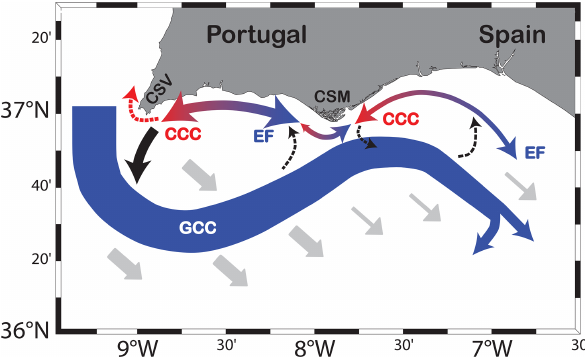
Figure 16. Updated sketch of the main circulation patterns at the NMGoC during the upwelling season for no-storm conditions. The flow magnitude (schematically represented by the size of the ar- rows) is larger at the western bight than at the eastern bight. Red (blue) arrows indicate the direction of warm (cold) water advec- tion. Dashed arrows indicate a transient (or sporadic) circulation. An equatorward slope current (the Gulf of Cádiz Current, GCC) proceeding from the west Portuguese coast and advecting cold wa- ter is superimposed to the background southeastward, wind-induced circulation (grey arrows). The GCC partly recirculates anticycloni- cally in the east. On the shelf, the flow is alongshore and balanced between the equatorward and poleward directions (as represented with equal double arrow head sizes), except near Cape Santa Maria (CSM). There, equatorward flows predominate (see the distinct dou- ble arrowhead sizes around the cape) as they reverse with some de- lay compared with the adjacent bights. However, the equatorward flows (advecting cold water) and poleward flows (advecting warm water) are generally continuous along the coast, reversing twice a week, on average. Poleward flows are coastal counter currents (CCCs), i.e. with a direction opposite to that of the GCC, which develop after periods of north-westerlies. At the western bight, they are associated with a cyclonic recirculation, strongest near Cape São Vicente (CSV), explaining the sporadic advection of warm water to the north of the cape (see the dashed red arrow near the cape). For weak wind stress, this recirculation depicts a short-lived eddy over the bight due to onshore recirculation near CSM (see the dashed ar- row near the cape). At the eastern bight, the CCCs and equatorward flows are strongest at the outer shelf (rather than at the inner shelf in the west). Cyclonic recirculation of CCCs occurs less frequently than in the west (see dashed